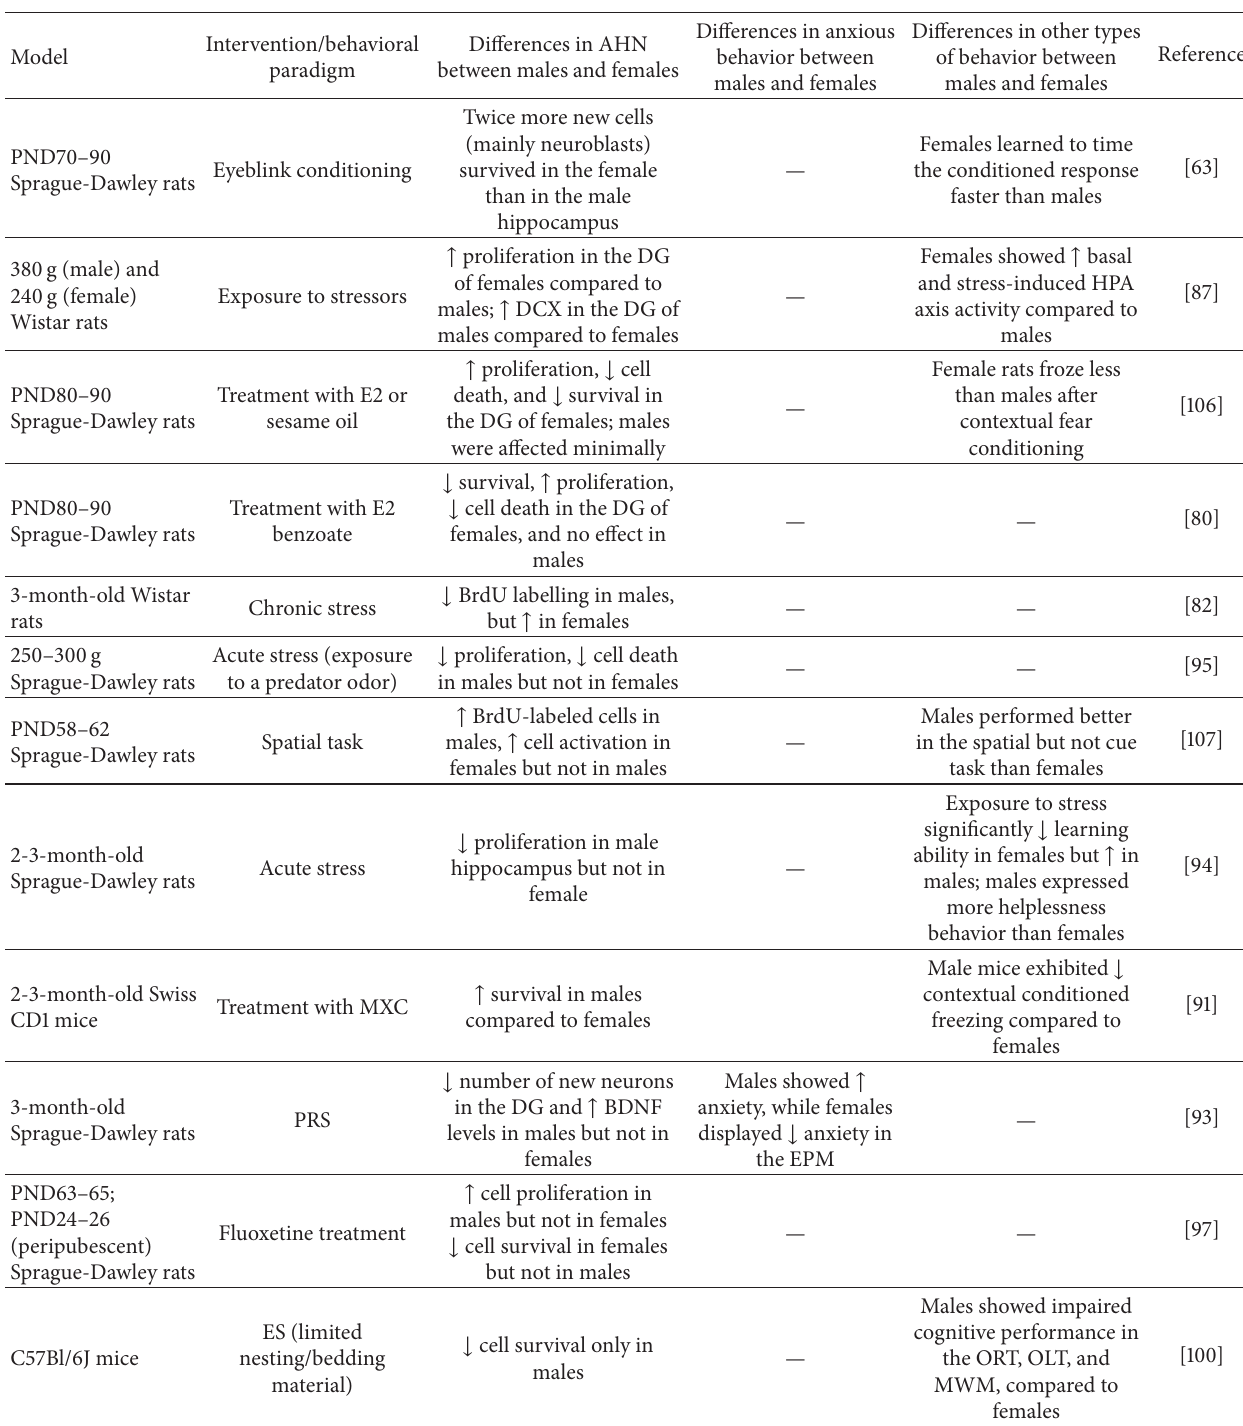
Table 1: Differences between males and females with regard to